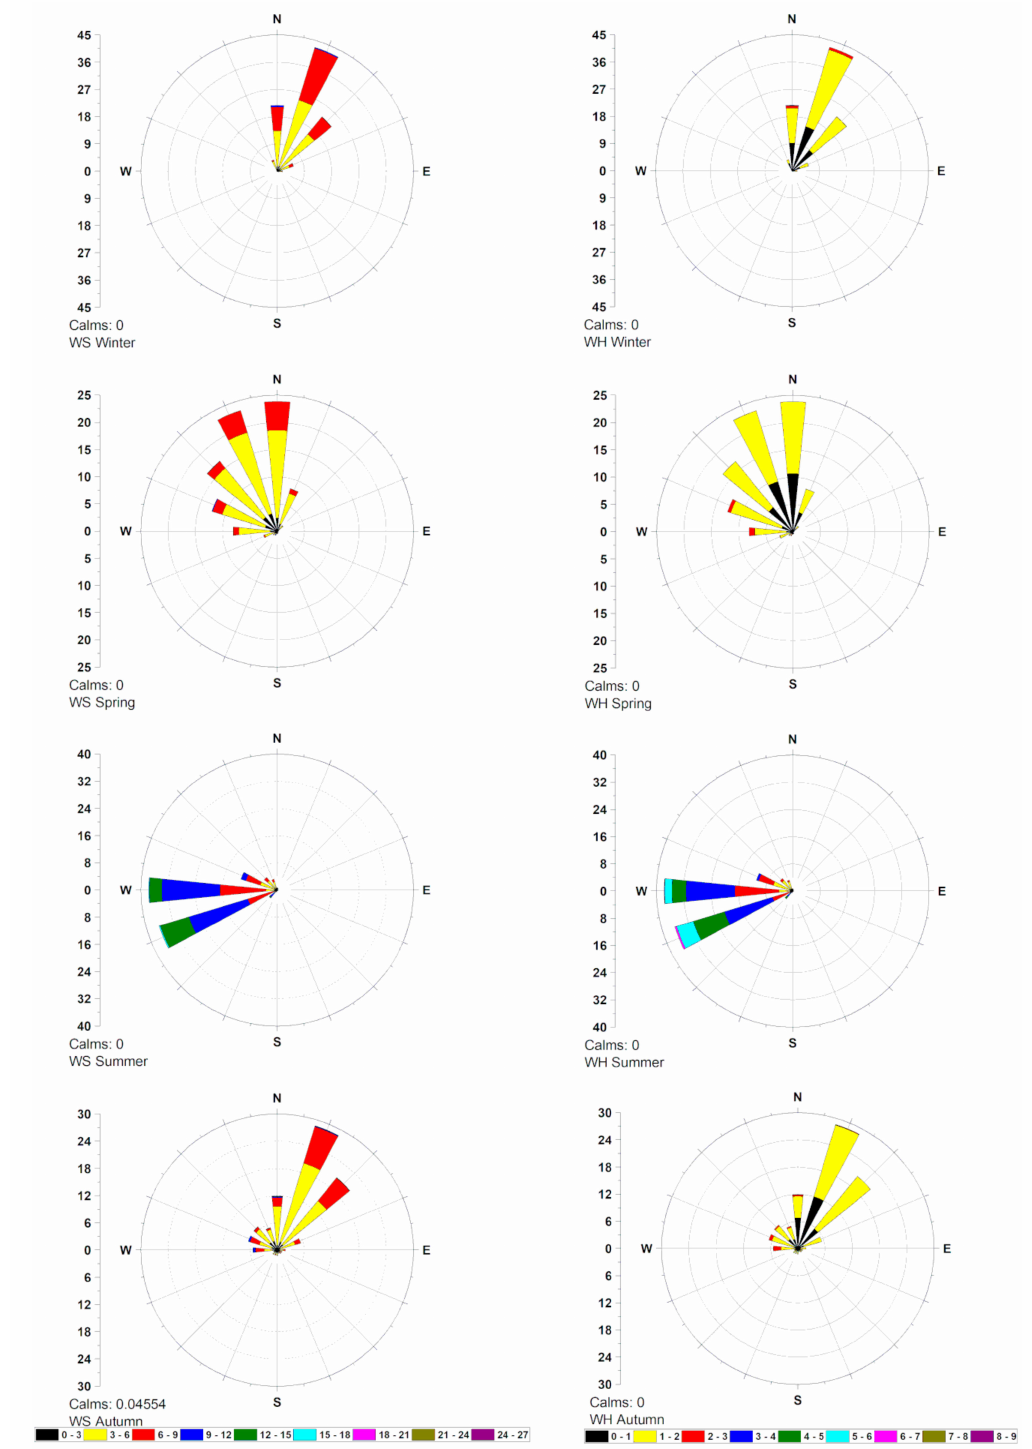
Figure 10. Pre-encroachment (2008–2010) seasonal hydrodynamics of the Karachi (WS = wind speed, WH = wave